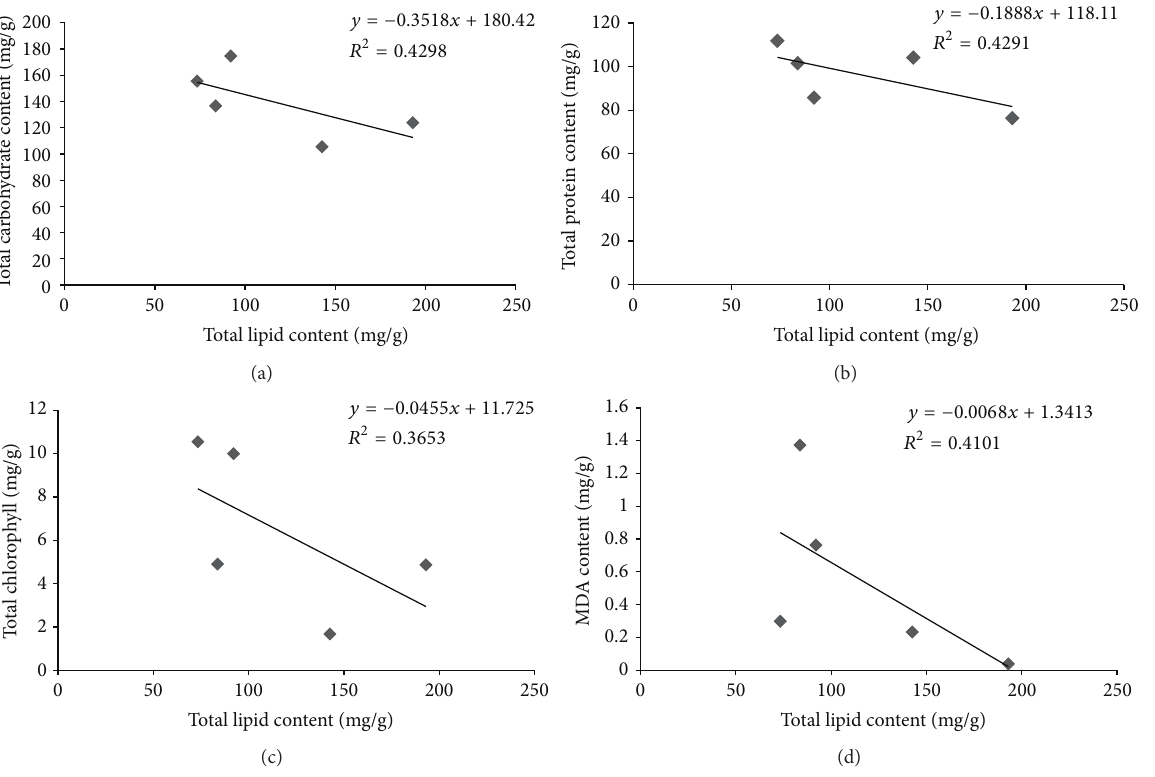
Figure 11: Showing linear regression plot of relationship between lipid and other bioactive compounds—chlorophyll, carbohydrate, protein, and lipid peroxidase